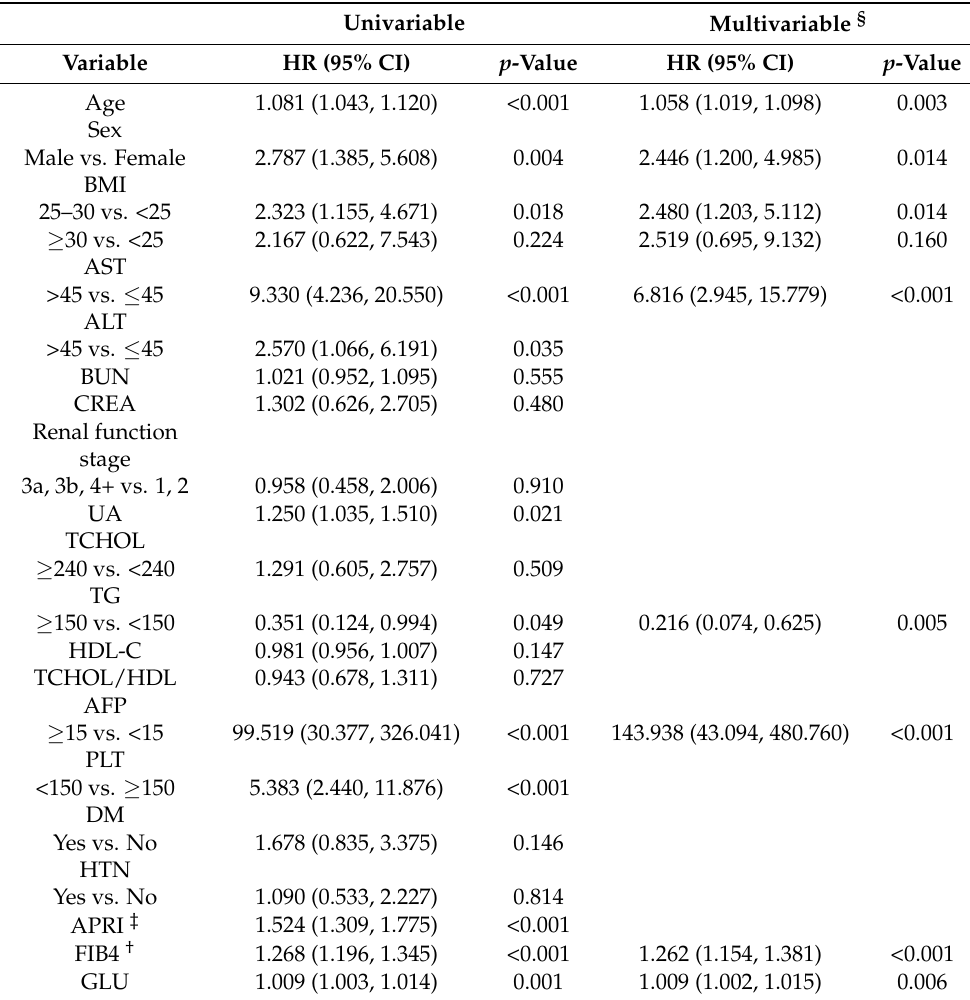
Table 2. Univariate and multivariate Cox proportional hazards model for predictors of HCC in non-B, non-C